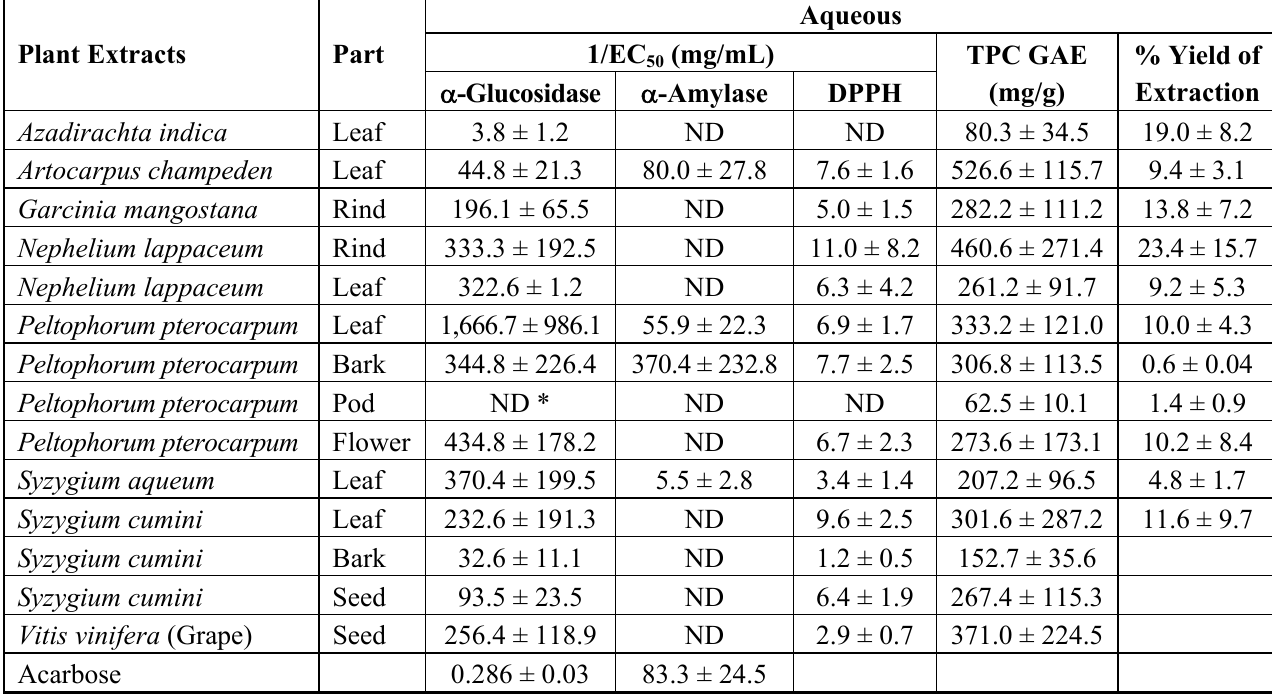
Table 3. 1/EC of  -glucosidase,  -amylase and DPPH activity, TPC and yield of aqueous 50 extraction of various plant extracts.